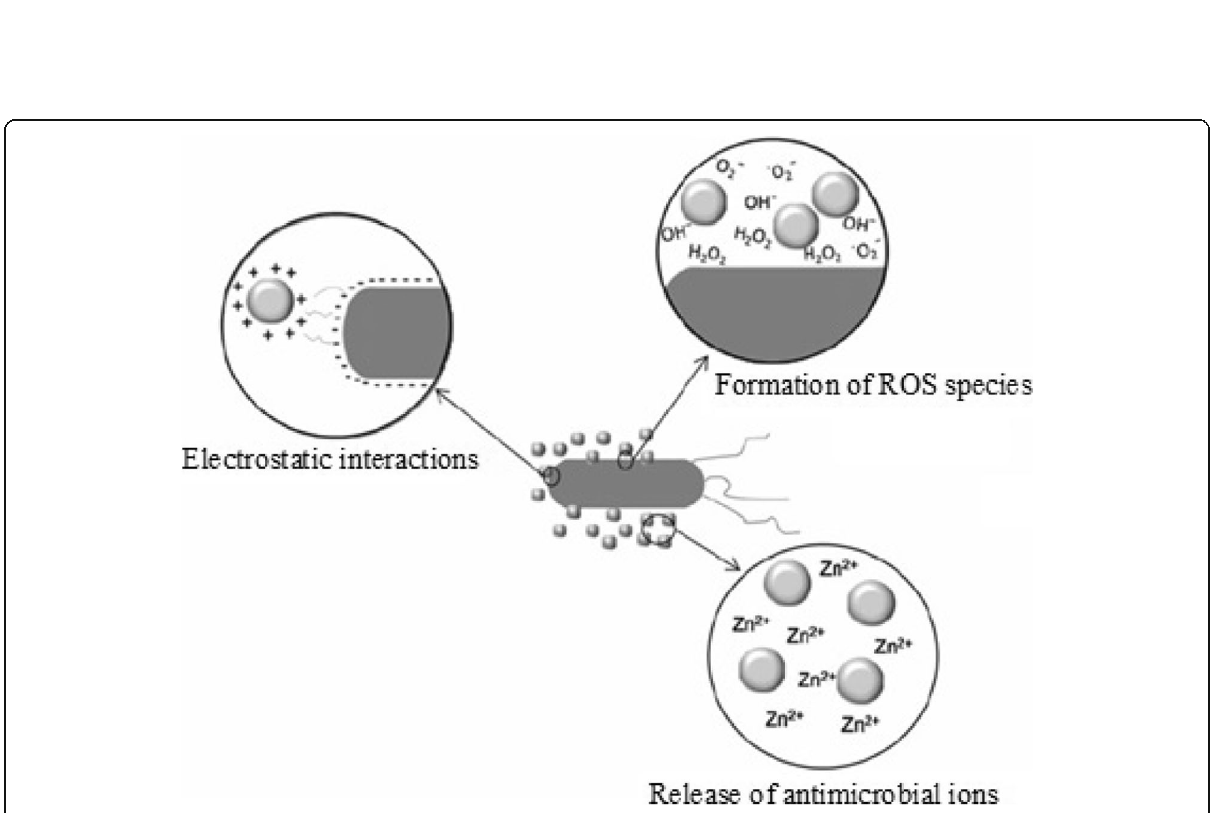
Fig. 2 Different mechanisms of antimicrobial activity of ZnO NPs (represented by gray spheres). Reproduced from ref. [30] with permission from Springer